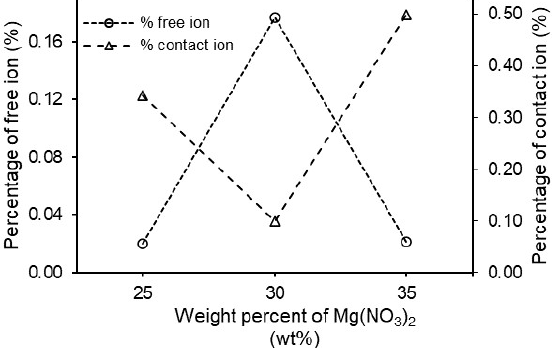
Figure 6. Graph of the percentage of free ions and contact ions for AMg25, AMg30 and AMg35 polymer electrolytes.